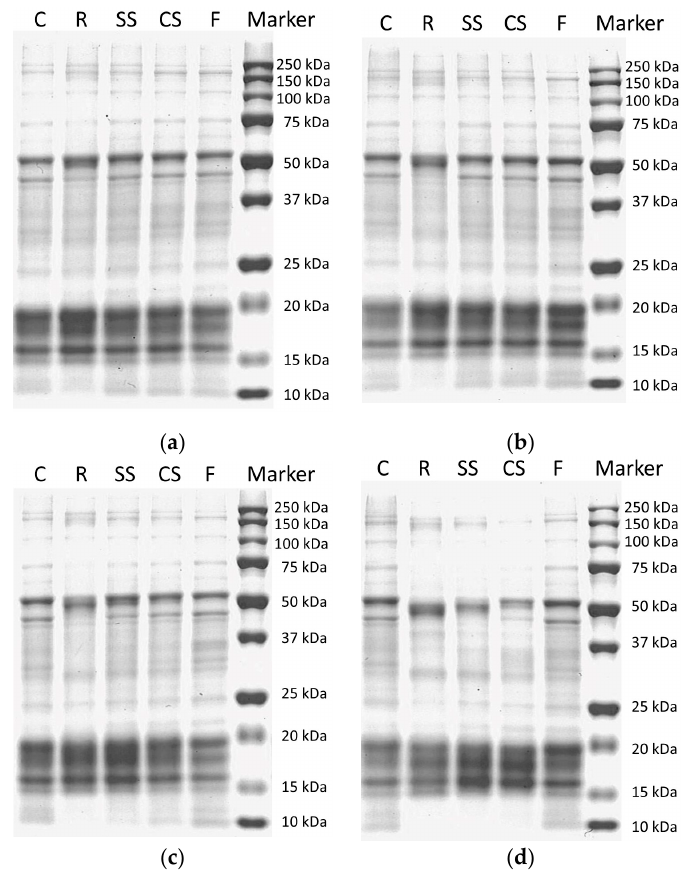
Figure 5. Sodium dodecyl sulfate-polyacrylamide gel electrophoresis (SDS-PAGE) of raw laver ( Pyropia yenzoensis ) depending on various storage methods and periods: ( a ) 3 days, ( b ) 6 days, ( c ) 9 days, and ( d ) 15 days. C, fresh sample; R, refrigeration; SS, supercooled by stepwise cooling algorithm; CS, constant temperature supercooling; F, freezing.